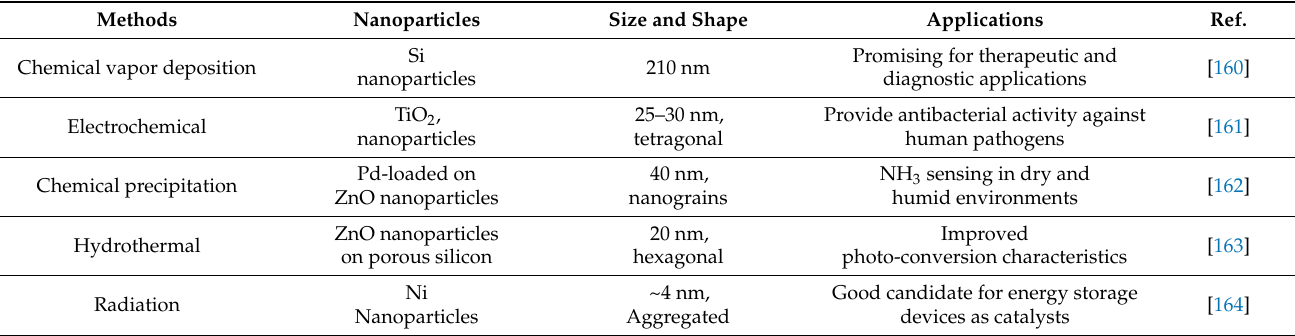
Table 3. Chemical and physiochemical techniques for the production of nanoparticles and